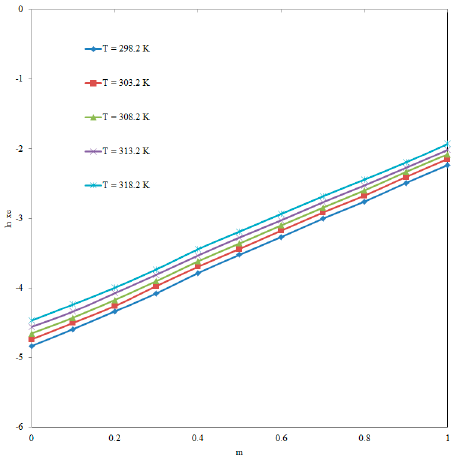
Figure 3. E ff ect of mass fraction ( m ) value of the PEG-400 on the solubility of ECT at “ T = 298.2 to 318.2 K”.